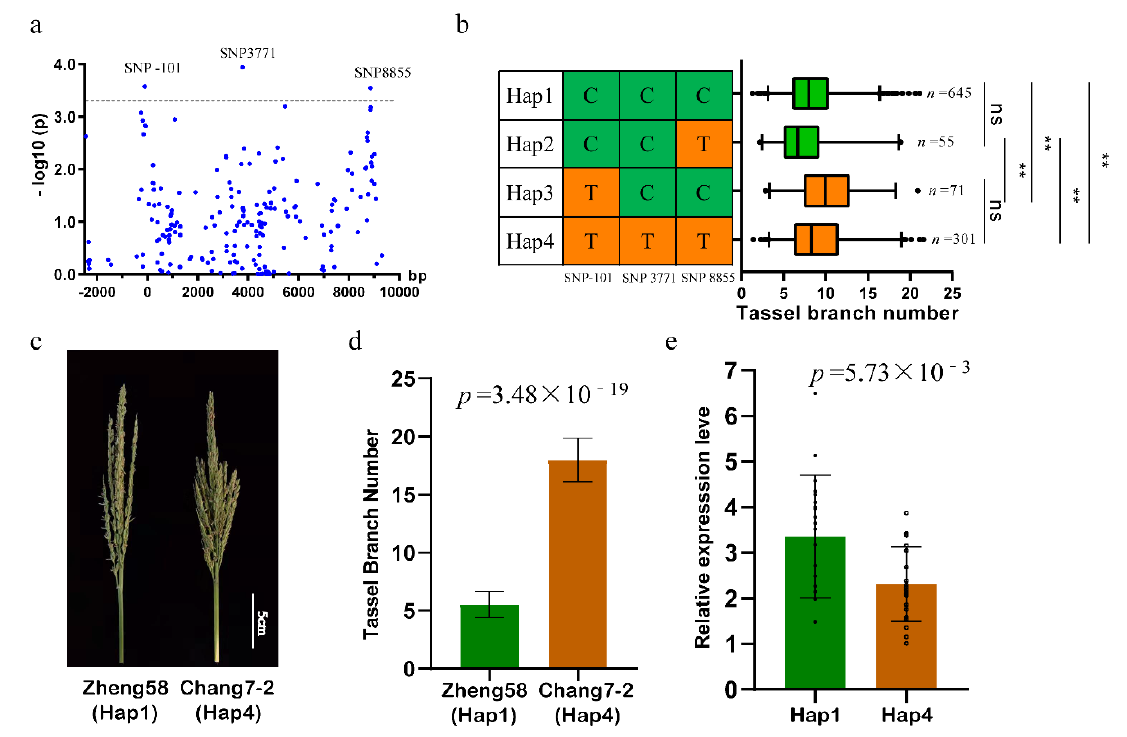
Figure 3. Genetic variations in the ZmPAT7 promoter are linked to TBN: ( a ) association analysis of the genetic variation in ZmPAT7 with TBN; ( b ) the TBN values of inbred lines of the four haplotypes are displayed in the box plot. Here, n denotes the number of inbred lines belonging to each haplotype group. Statistical significance was determined using a two-sided t -test. ** indicates significant difference at 0.01 level; ns indicates no significant difference. Image ( c ) and statistics ( d ) show the TBN differences between Zheng58 and Chang7-2. Values are represented as mean ± SD, and the p values of two-sided t -test are shown; ( e ) expression analysis of ZmPAT7 between the 20 lines with Hap1 and the 20 lines with Hap4.